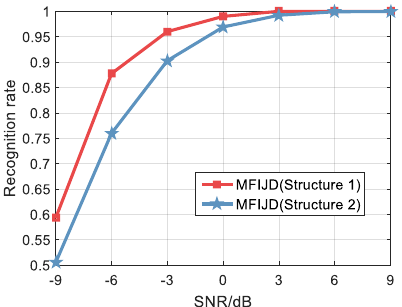
Figure 16. The classification result of the MFIJD in the test set.